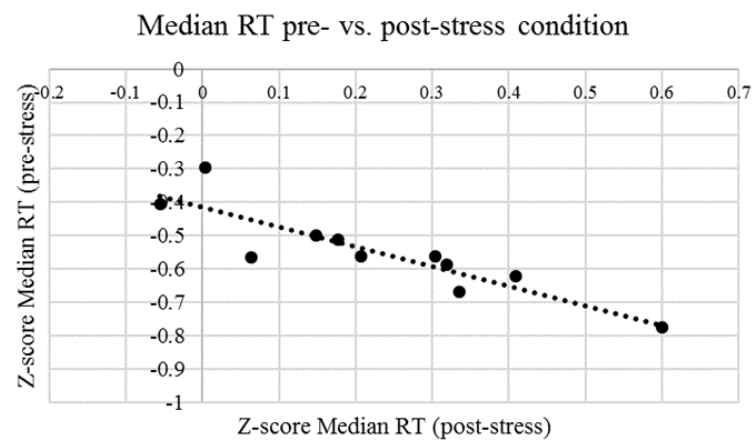
Figure 6. Graphic representing the relation between Z-score Median reaction time (RT) pre- (CRTT1) and post-stress (CRTT2) conditions and corresponding fit line. Each dot point in the graphic represents each subject.